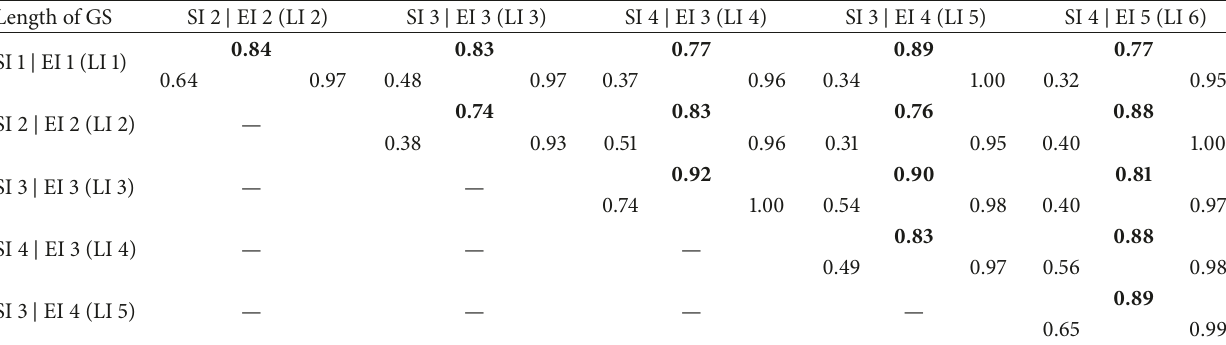
Table 4: Correlation coefficients for combinations of indices of growing season length. Single bold values show the mean coefficient over northern China, and the paired values below show the minimum (left) and maximum (right) coefficients. Length of GS SI 2 | EI 2 (LI 2) SI 3 | EI 3 (LI 3) SI 4 | EI 3 (LI 4) SI 3 | EI 4 (LI 5) SI 4 | EI 5 (LI 6) 0.84 0.83 0.77 0.89 0.77 SI 1 | EI 1 (LI 1) 0.64 0.97 0.48 0.97 0.37 0.96 0.34 1.00 0.32 0.95 0.74 0.83 0.76 0.88 SI 2 | EI 2 (LI 2) 0.38 0.93 0.51 0.96 0.31 0.95 0.40 1.00 0.92 0.90 0.81 0.74 1.00 0.54 0.98 0.40 0.97 0.83 0.88 0.49 0.97 0.56 0.98 0.89 0.65